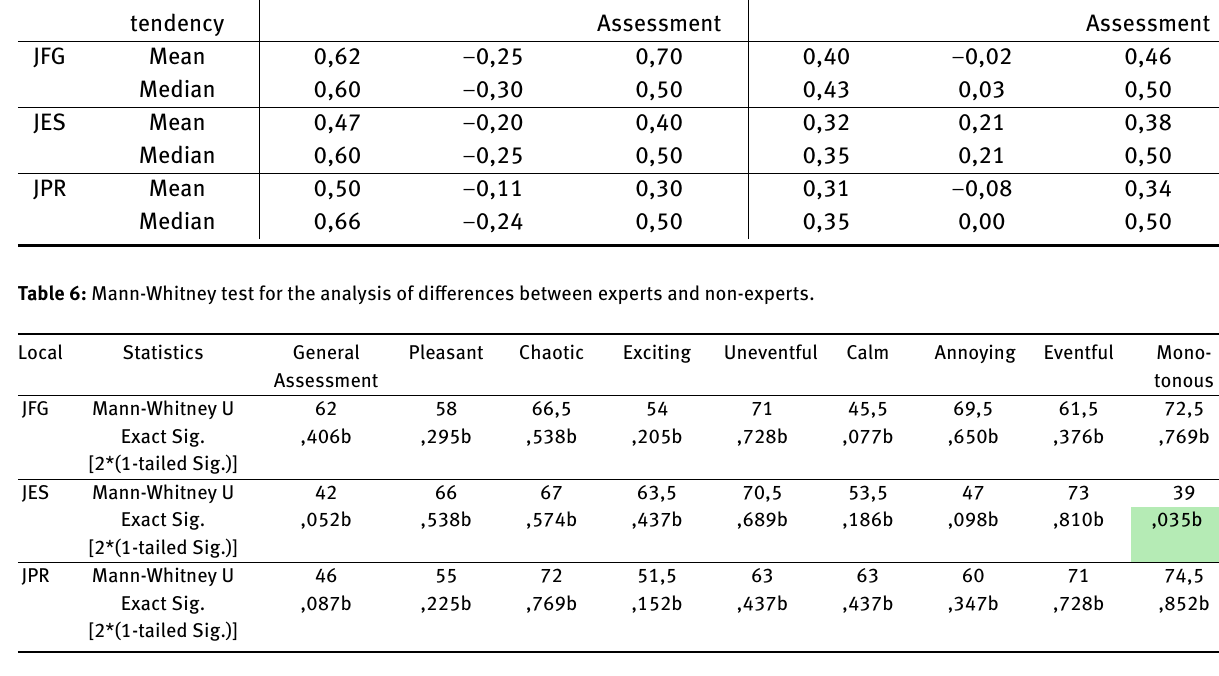
Pleasantness Eventfulness General Assessment